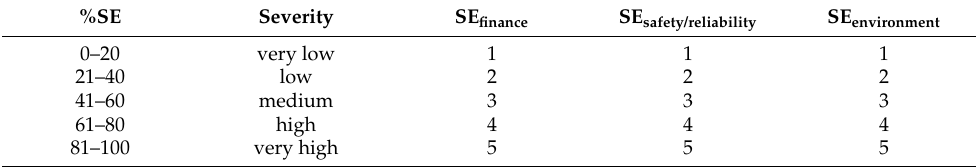
Table 9. %SE and severity score for the financial, safety/reliability, and environmental